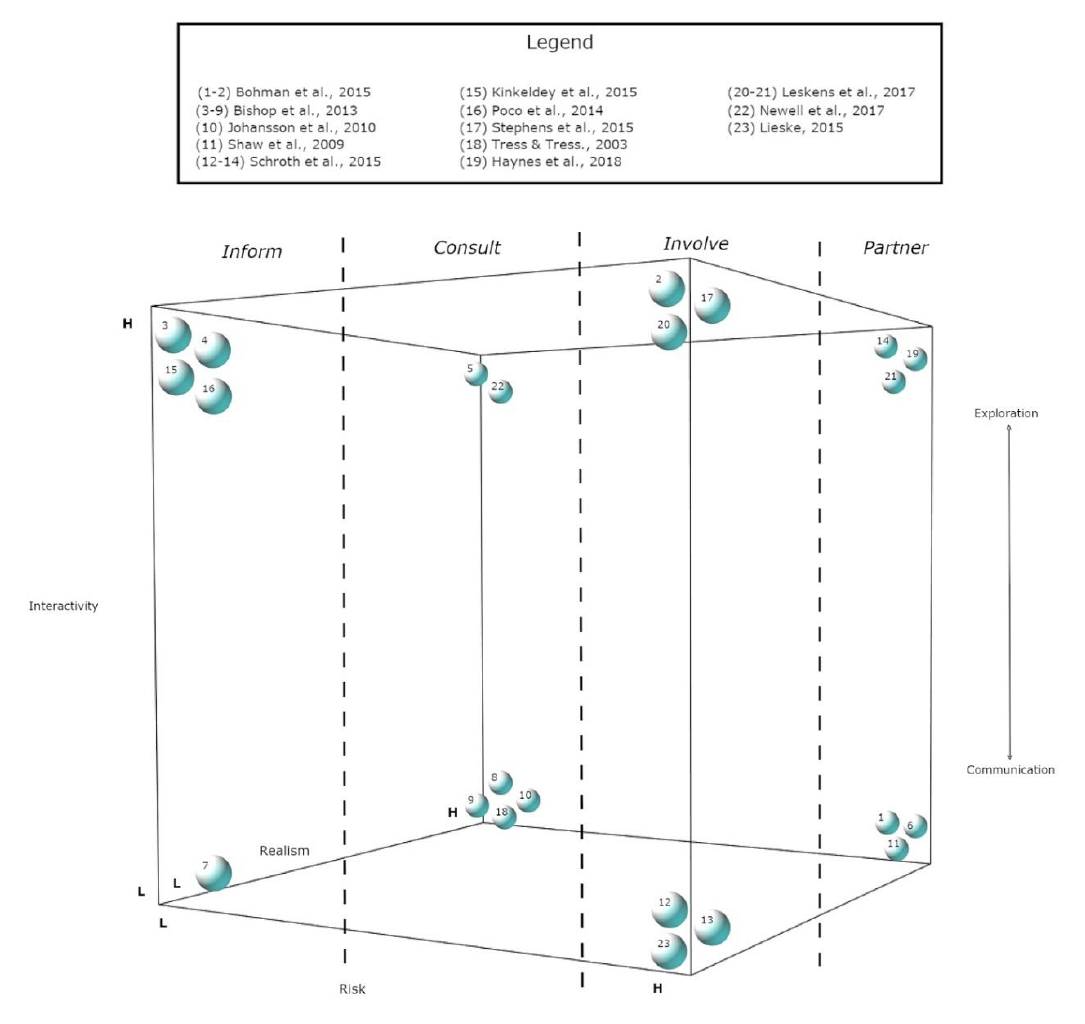
Figure 3. CVAP populated with geovisualization products.